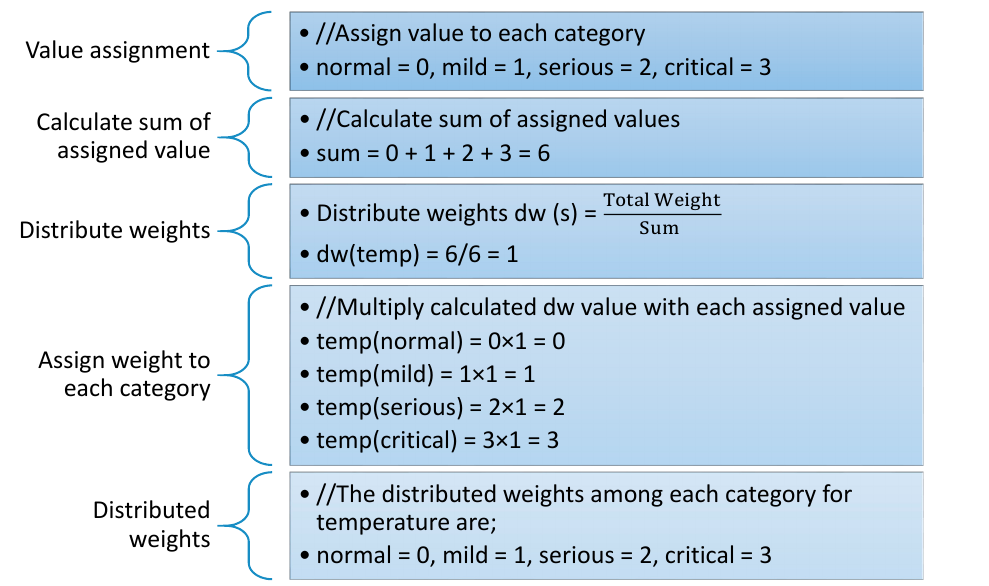
Algorithm 2. The mathematical process of weight distribution among each category.